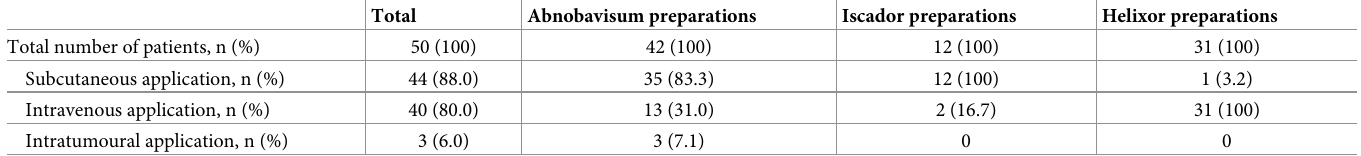
One hundred and fifty-eight patients were included in the overall survival (OS) analysis from which 86% (n = 136) died during total observational time with 24.1% (n = 38) in the CTx + VA group and 62% (n = 98) in the CTx only group. As to overall survival a survival benefit was seen for the combinational treatment (CTx + VA) compared to CTx only, see Figs 2 and 3. The median OS was 17.0 months in the CTx plus see Table 4. This difference was statistically significant ( χ 2 = 7.2, p = .007). One-year OS rates Table 3. Number of stage IV NSCLC patients receiving additional VA to standard